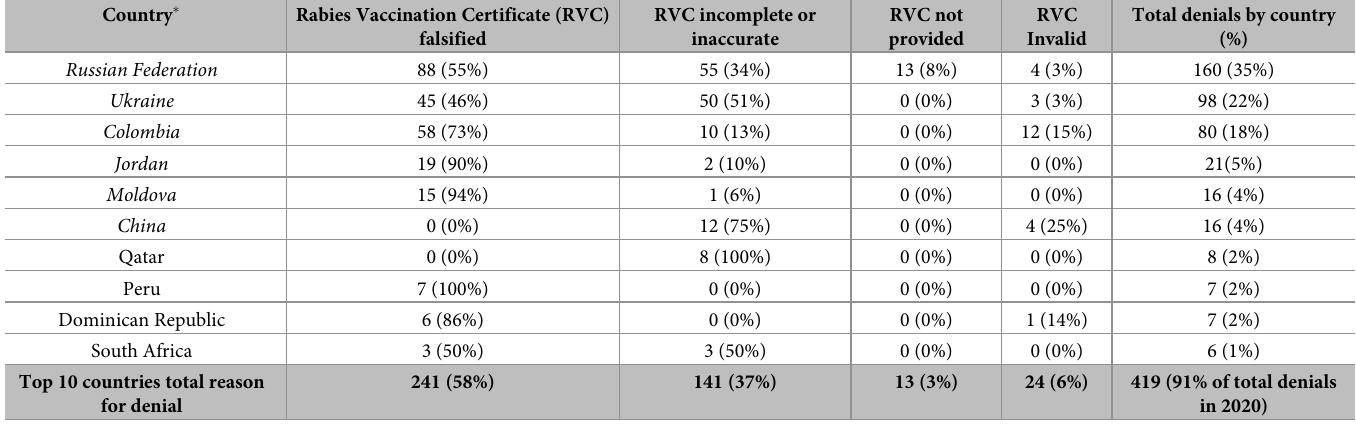
Table 2. Reasons for dog entry denials by country for the top ten countries of origin, United States, 2020. Country � Rabies Vaccination Certificate (RVC)